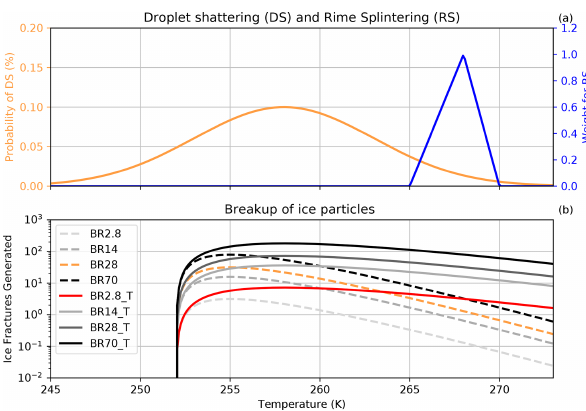
Figure 2. Secondary ice production processes at their defined tem- perature ranges. Panel (a) shows the probability of occurrence of droplet shattering (DS) and the triangular weighting function of rime splintering (RS). Panel (b) shows the fragment numbers gener- ated by ice–graupel collisional breakup (BR) for the different cases shown in Table 1. The red and yellow lines in (b) are the collisional breakup parameterizations that were analyzed in the